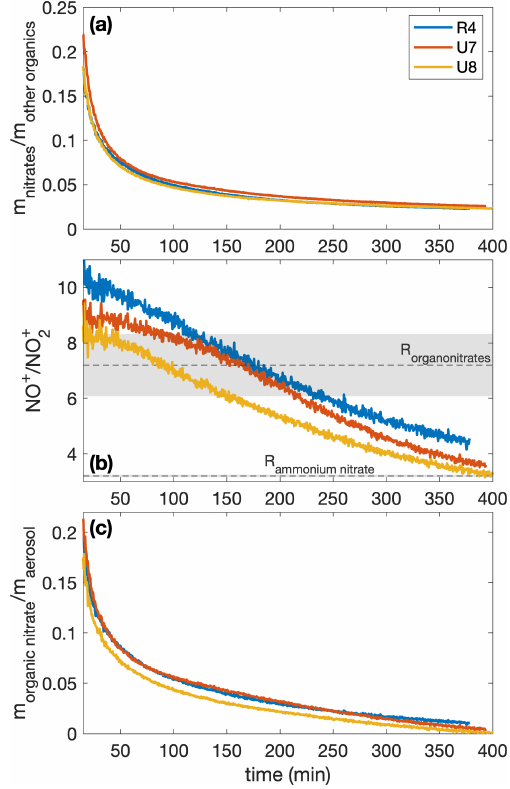
Figure A1. The mass ratios of (a) the nitrates to organics without nitrogen, (b) the NO + to the NO + signal from the AMS, and (c) the 2 organonitrate to total organic aerosol mass for experiments R4, U7, and U8. All experiments were performed under similar initial condi- tions (291K, [NO] 0 = 71–77ppb). Since the ratios are relevant only when there is a sufficient amount of aerosol present, the first 15min after oxidation are not shown. In panel (b) , the assumed organoni- trate and ammonium nitrate NO + x ratios are shown as dashed lines with the uncertainty as the corresponding shaded